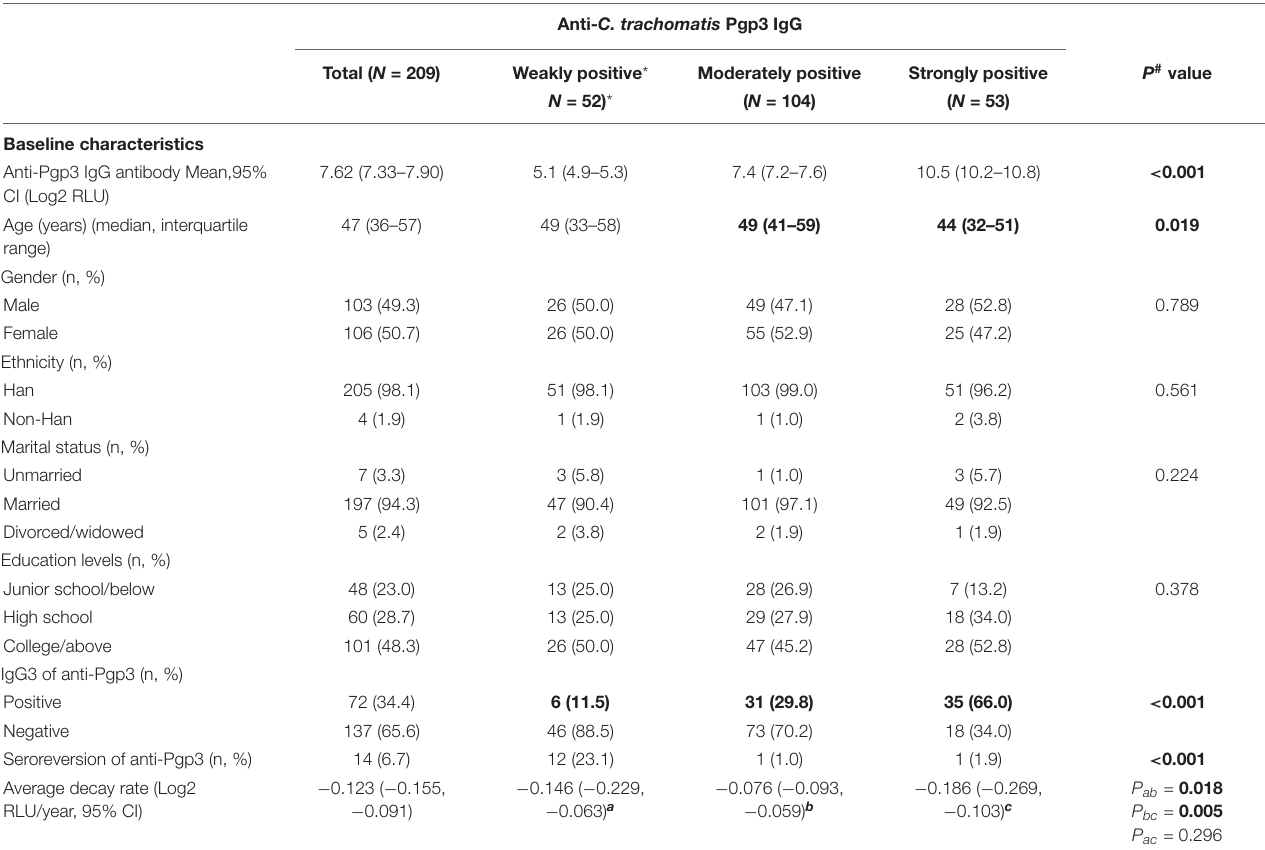
TABLE 5 | Characteristics of C. trachomatis seropositive subjects with different titers of anti-Pgp3 IgG